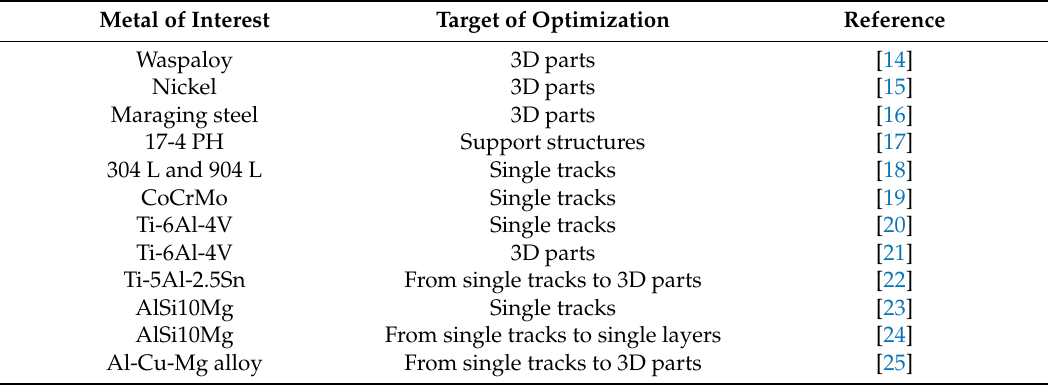
Table 1. Representative literature on process parameter optimization for specific